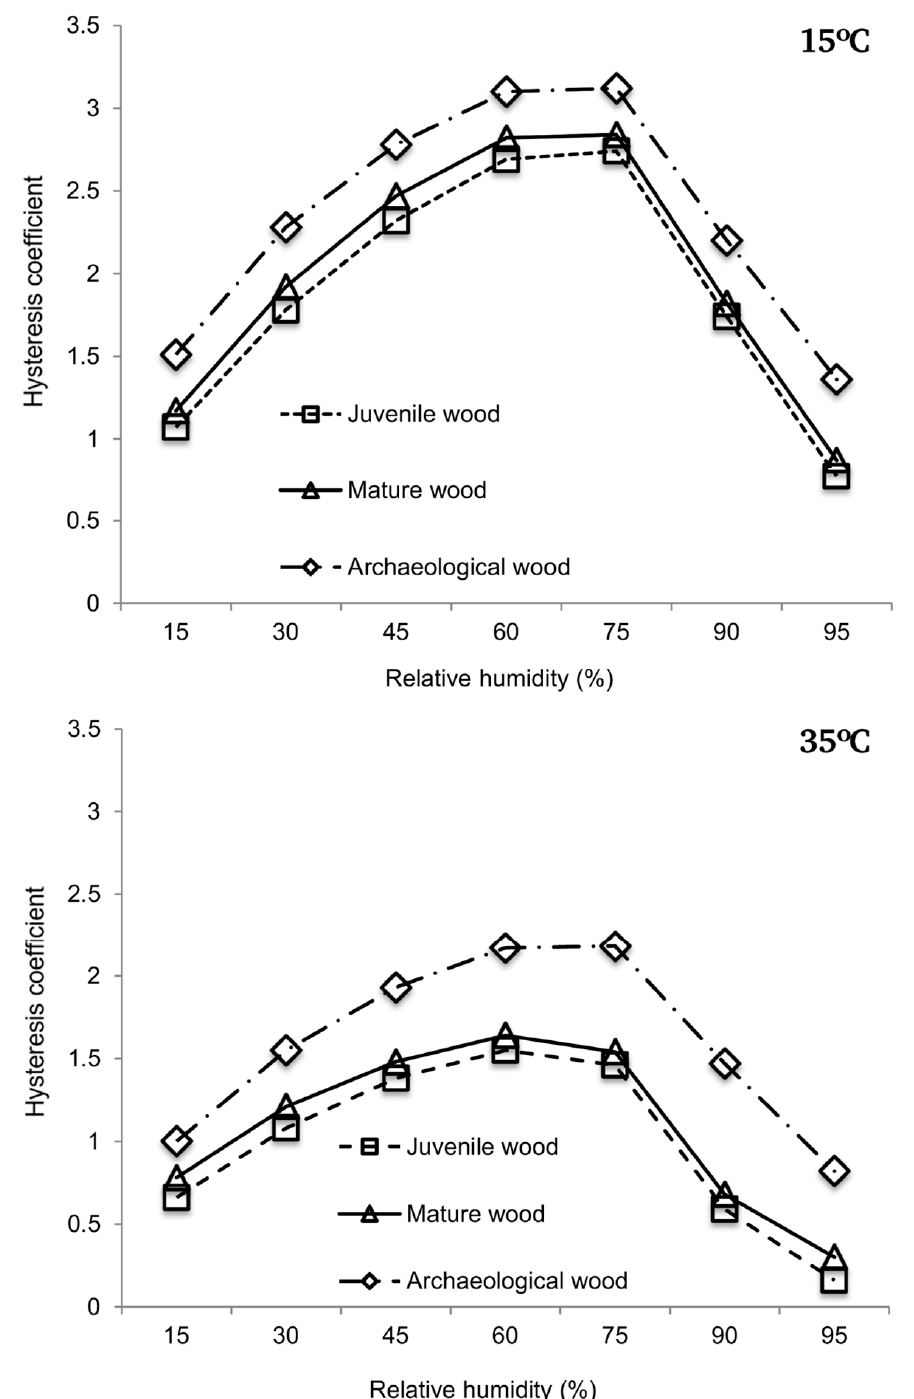
Figure 4. Hysteresis coefficients for the 15 °C and 35 °C isotherms determined by the difference between desorption equilibrium moisture content (EMC) and adsorption EMC.